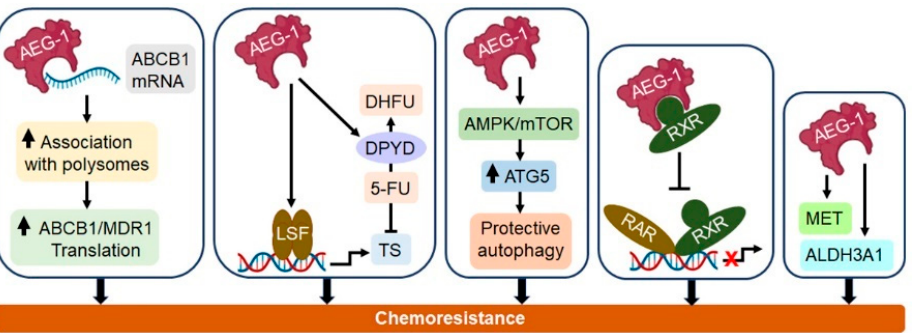
Figure 3. Important molecular mechanisms by which AEG-1 induces chemoresistance. AEG-1 binds to the multidrug resistance 1/ATP binding cassette subfamily B member 1 (MDR1/ABCB1) mRNA and increases its translation, thereby causing doxorubicin resistance. AEG-1 induces the transcription factor late SV40 factor (LSF), resulting in an increase in thymidylate synthase, the substrate of 5-fluorouracil (5-FU), and increases the 5-FU-metabolizing enzyme dihydropyrimidine dehydrogenase (DPYD), collectively resulting in 5-FU resistance. AEG-1 activates the AMP-activated protein kinase/mammalian target of rapamycin (AMPK/mTOR) pathway, resulting in increased ATG5 and protective autophagy, which confer a resistance to doxorubicin and 5-FU. AEG-1 interacts with retinoid X receptor (RXR), inhibiting retinoic acid receptor (RAR)/RXR-mediated gene regulation and thereby causing a resistance to retinoic acid. The AEG-1-induced expression of MET proto-oncogene, receptor tyrosine kinase (MET) and aldehyde dehydrogenase 3 family member A1 (ALDH3A1) resulted in a resistance to paclitaxel, doxorubicin and 4-hydroperoxycyclophosphamide (4-HC). See the text for more details.